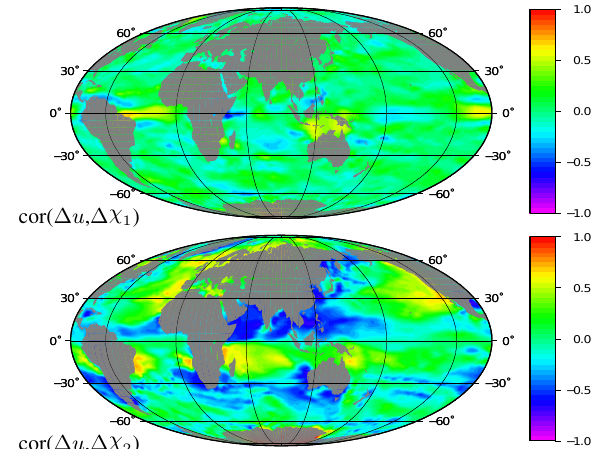
Fig. 3. Temporal correlation of the changes induced by the assimilation procedure: Correlations between changes in the model’s zonal surface velocity and the change in modeled χ 1 (top) respectively χ 2 (bottom). tribution to PM would vanish in this case. Therefore, it is only due to the symmetry-breaking of the continents that the black line in Fig. 2 is not zero. Consequently, the major frac- tion of the mass-term can be attributed to the redistribution 145 of oceanic mass. In search for the physical mechanisms that are respon- sible for the generation of the modeled PM-excitation we focused on the changes in the model-state done by the as- similation.